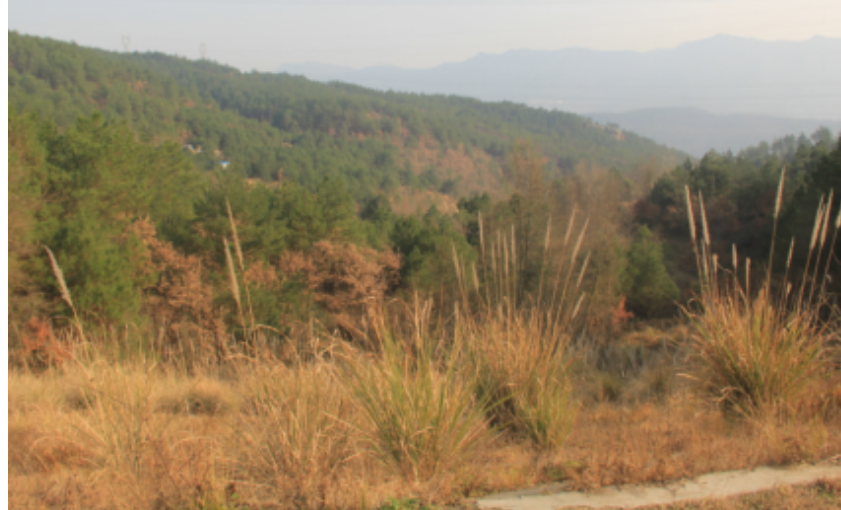
Figure H1. Vegetation distribution in a watershed in the study area.